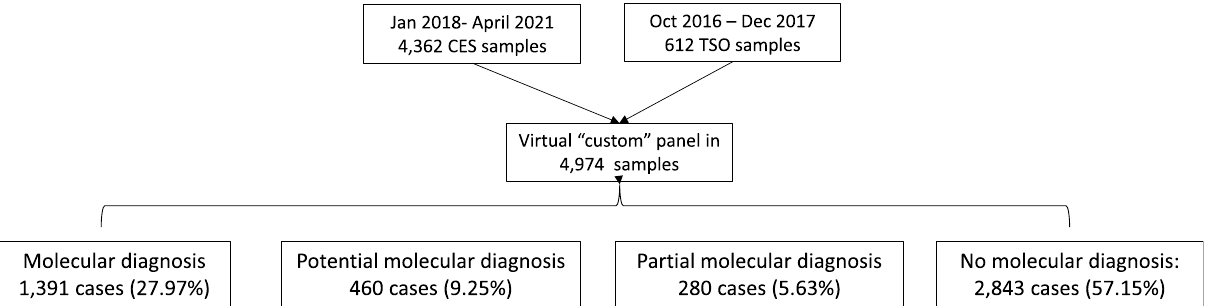
Figure 1. Summary and overview of the 4974 analysed cases. “Molecular diagnosis”: a P or LP variant in a dominant or X linked gene; as two P or LP, one P and one LP variant in a recessive gene, respectively, sex regardless; “Potential molecular diagnosis”: a VUS in a dominant gene potentially explaining the phenotype, two VUS in a recessive gene potentially explaining the phenotype or VUS in a X-linked gene. “Partial molecular diagnosis”: only one P or LP variant in a recessive gene (monoallelic) potentially explaining the phenotype. “No molecular diagnosis”: no variants or either a monoallelic P, LP or VUS in recessive gene or a VUS in a dominant gene not clearly related with the clinical suspicion were reported.